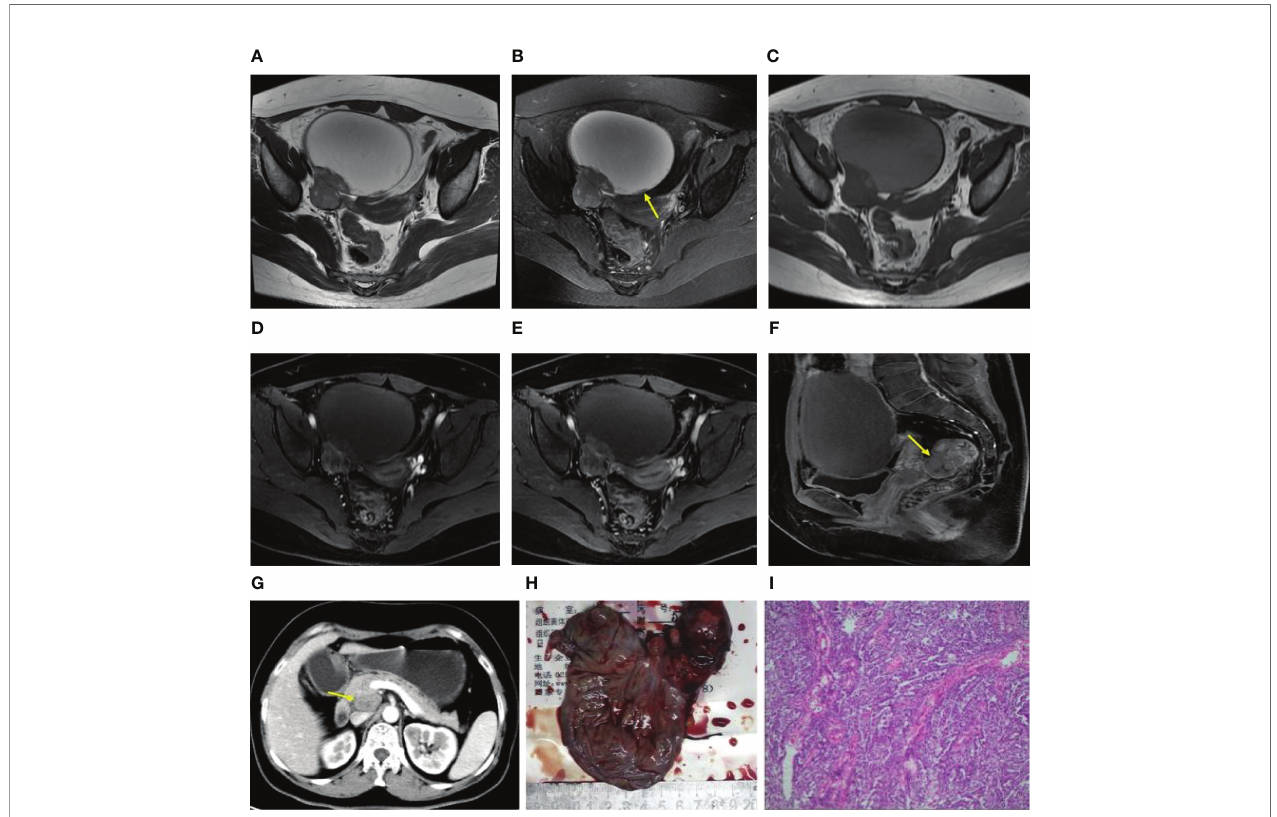
FIGURE 1 | (A – I) Axial T2WI and FS T2WI showing a cystic solid mass with a capsule wall nodule [yellow arrow, (B) ]. T1WI (C) displayed high signal in the liquid region of the mass. In the arterial, venous and delayed period, the solid region of the mass revealed severe enhancement, more than the gluteal muscle (D – F) . A metastatic nodule was seen in the rectouterine depression [yellow arrow, (F) ]. Postoperative follow-up revealed a retroperitoneal metastatic lymph node [yellow arrow, (G) ]. Postoperative gross specimen and HE staining at low magni fi cation showed a high-grade serous carcinoma (H, I)